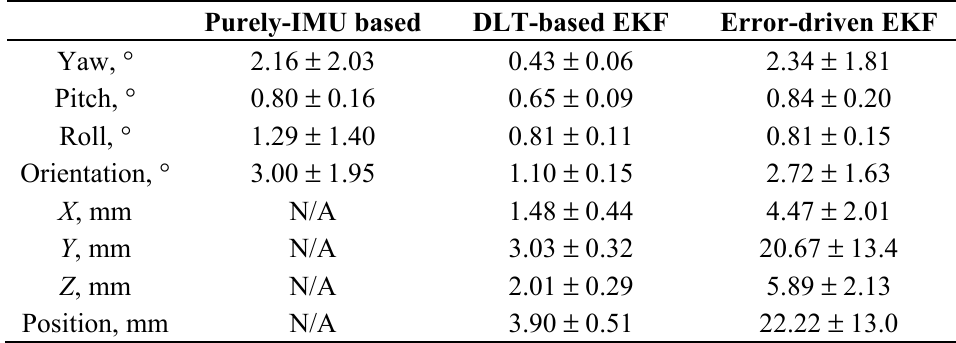
Table 4. Summary statistics of the performance metrics in the scenario